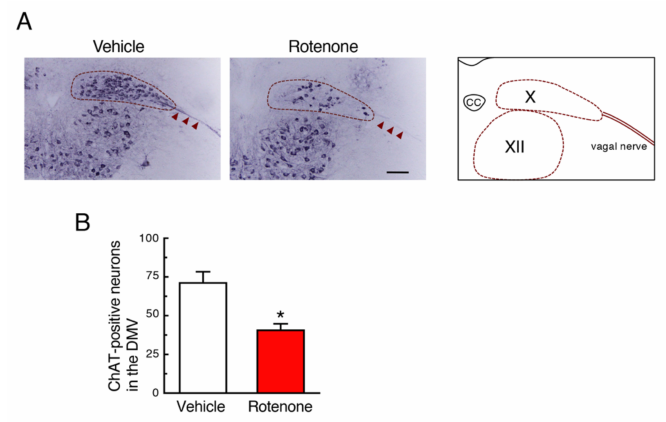
Figure 3. Chronic exposure to low-dose rotenone induced cholinergic neurodegeneration in the dorsal motor nucleus of the vagus (DMV) of mice. ( A ) Representative photomicrographs of immunohistochemistry for choline acetyltransferase (ChAT) in the DMV of mice 4 weeks after rotenone treatment. Scalebar = 100 µ m. CC:centralcanal,X:DMV,XII:hypoglossalnucleus. Arrowheads: Vagalnerve. ( B ) Changes in the number of ChAT-positive neurons in the DMV. Each value is the mean ± SEM ( n = 4). * p < 0.05 vs. the vehicle-treated control group (two-tailed unpaired independent t -test). 2.4. Chronic Exposure to Low-Dose Rotenone Induced Neurodegeneration in the Intestinal Myenteric